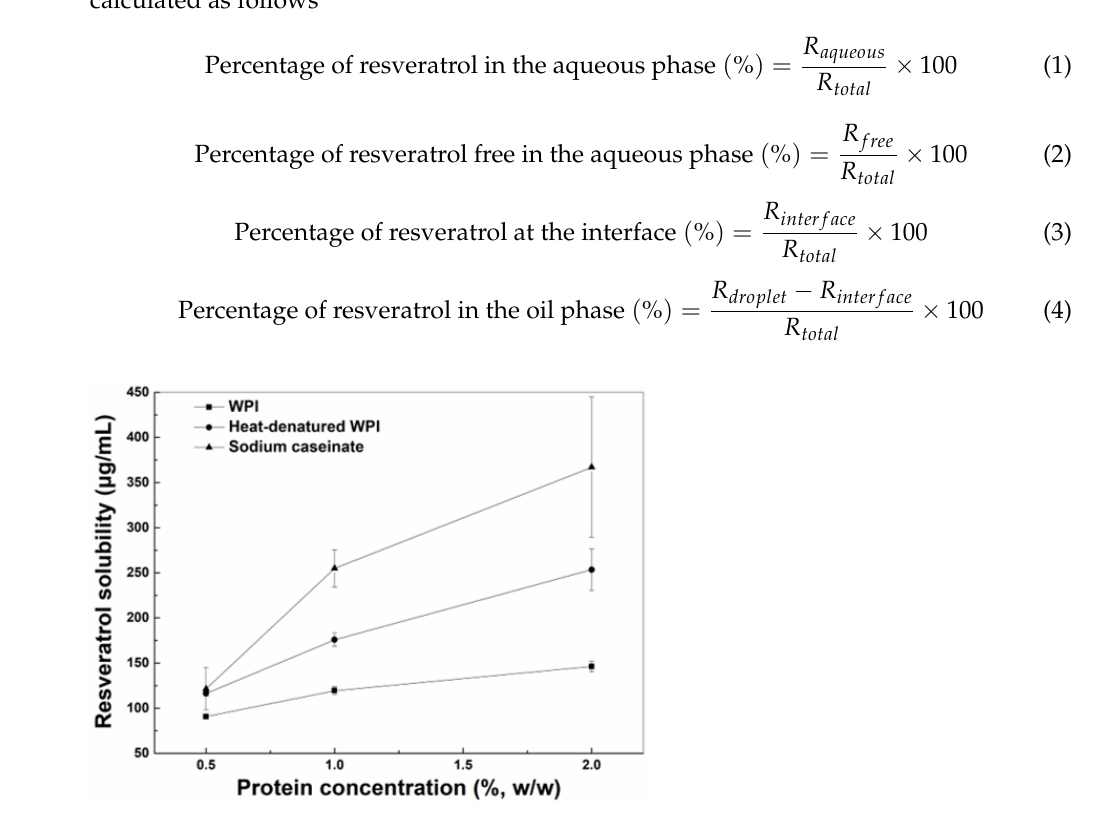
Figure 1. Solubility of resveratrol in the aqueous solution with WPI, heat-denatured WPI and sodium caseinate as a function of protein concentration.